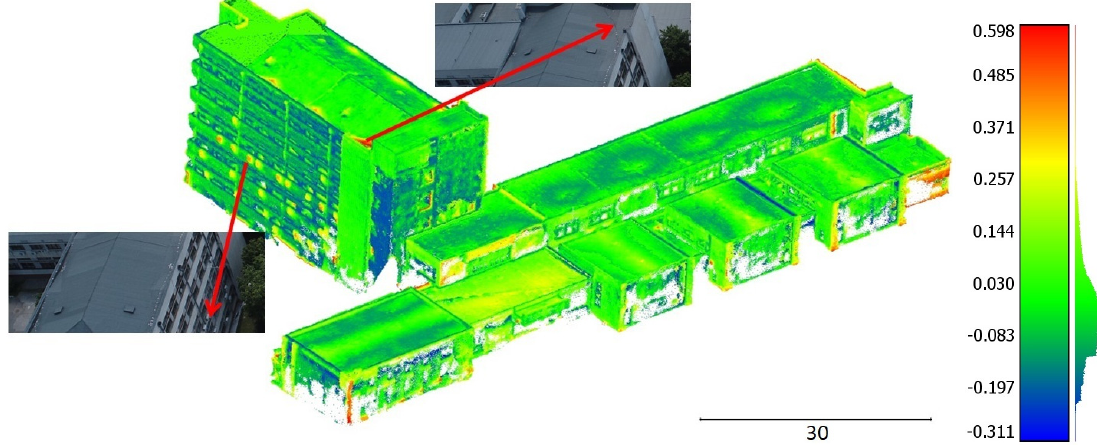
Figure 29. The distances in meters between the UAS point cloud and the rectory building parametrized 3D model.